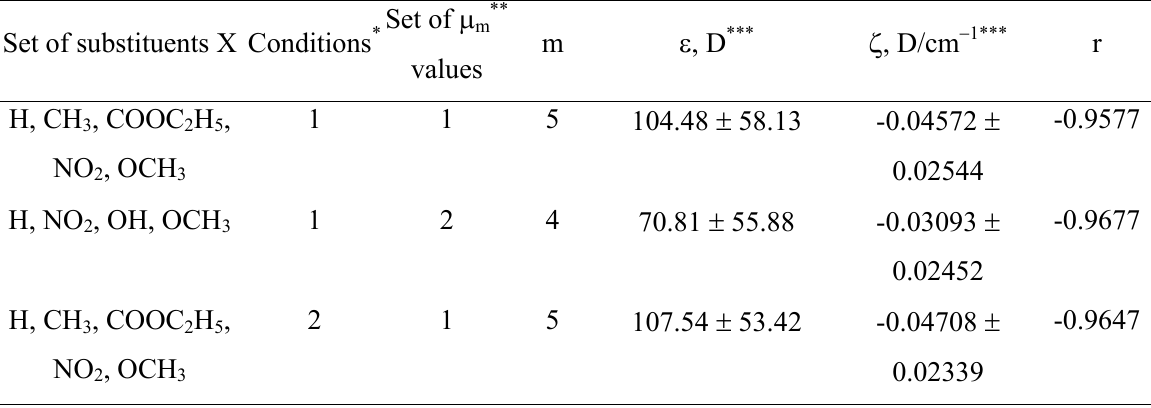
Table 4i. Correlations of mesomeric dipole moments of X substituents with stretching vibrational frequencies ( ν ) for fragment C-N + ≡ N bonds in aryldiazonium cations 2-XC